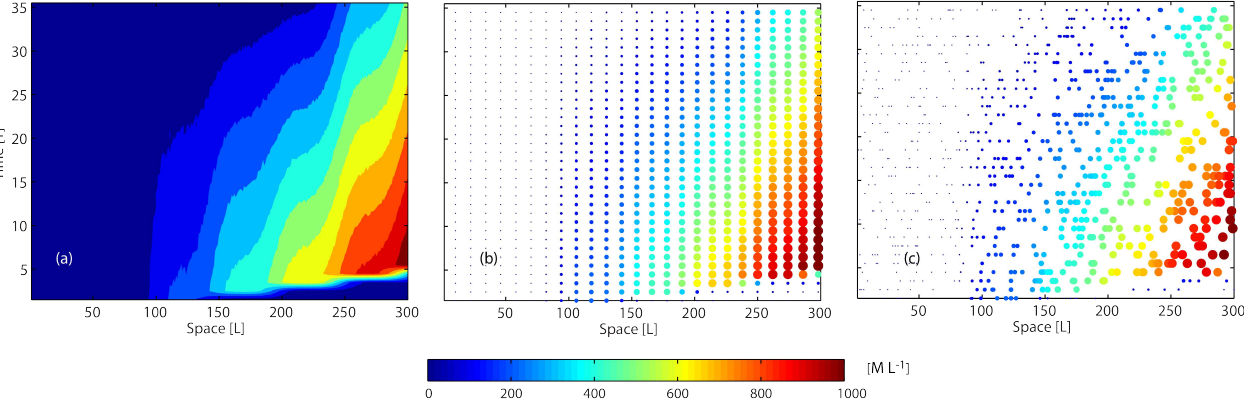
Fig. 2. Observations of the tracer obtained from the three network configurations – REF (a) , HM (b) , and HT (c) . Note that going from the REF to the HM and the HT networks, the total number of observations decreases by a factor of 12, whereas in going from the HM to the HT network, the observational network becomes more heterogeneous in space and